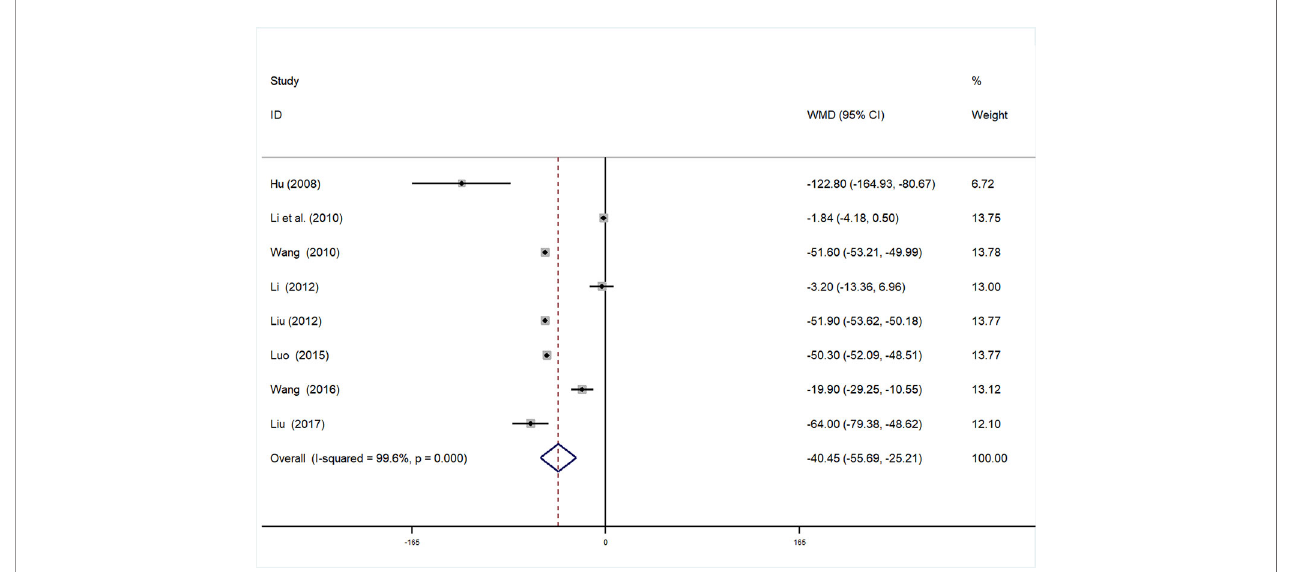
FIGURE 10 | Forrest plot of